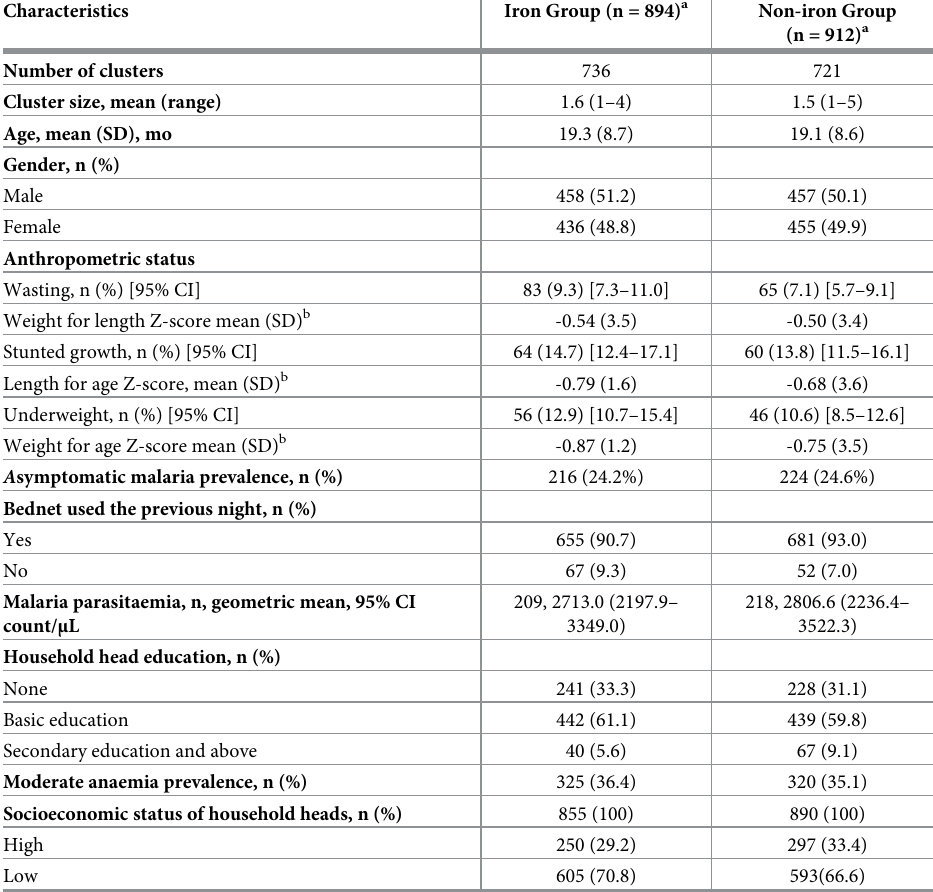
Table 1. Baseline characteristics amongst the children.